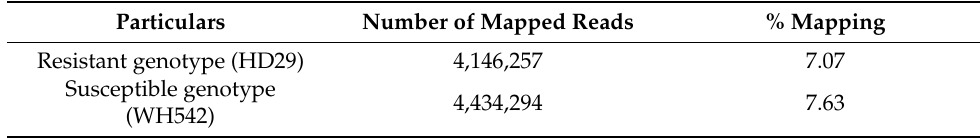
Table 3. Mapping statistics with T. indica genome.